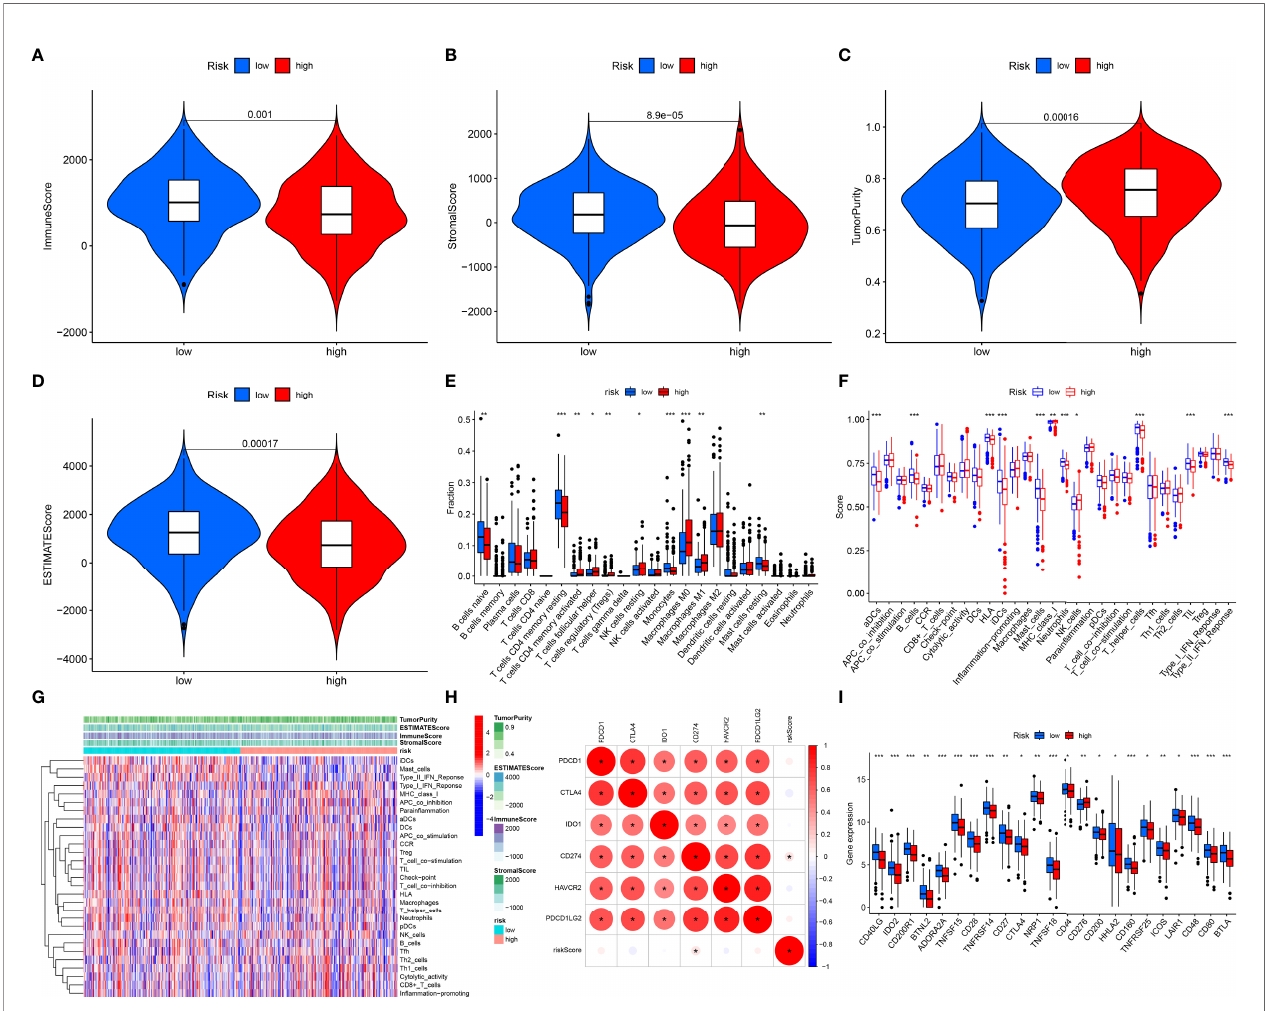
FIGURE 5 | Associations of prognostic model with immune microenvironment across LUAD patients. (A – D) Distribution of estimate, immune, and stromal score and tumor purity in different risk groups. (E) Comparisons of the levels of tumor immune in fi ltration in different risk subpopulations with CIBERSORT algorithm. (F) Comparisons of the abundance levels of immune cell in fi ltrations and immune functions in different risk subpopulations utilizing ssGSEA algorithm. (G) Heatmap visualizing the distribution of the abundance levels of immune cell in fi ltrations and immune functions. (H) Associations of risk score signature and common immune checkpoint molecules across LUAD. (I) Comparisons of the expressions of immune checkpoint molecules in different risk subpopulations. *P < 0.05; **p < 0.01; ***p <